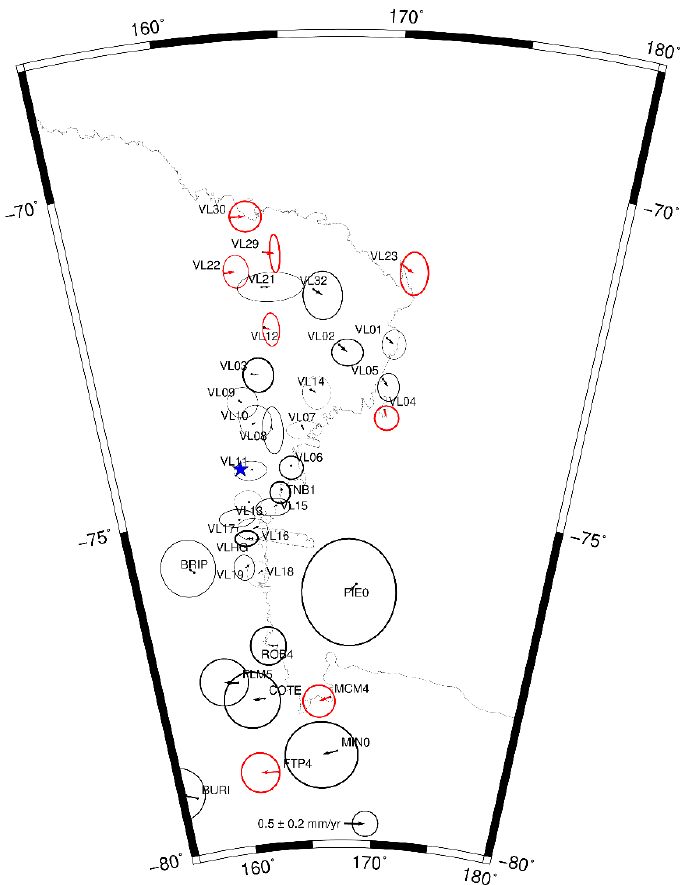
Figure 2. The difference between the relative velocities of the GNSS stations obtained using VLNDEF18 Euler pole and those obtained using the VLNDEF20 pole. Significant vectors are highlighted in red according to the ±σ criterion; blue star in the middle of the figure identifies the Euler pole of the differences. The horizontal principal strain rate and dilatation were evaluated at a center of each square cell of a regularly spaced grid, by means of the grid-distance-weighted approach [43,45–47]. The computation was done using all the 36 GNSS stations of the area and a distance weighting factor alpha of 38.67 km. Weighting data by distance produces a smoothed regional pattern strain and rotation rate field and is particularly effective to visualize the regional patterns over large areas. A grid spacing of 20 km was adopted to display the strain directions in the graphs in a more readable way, while a grid spacing of 5 km was adopted to highlight, by means of colored areas in the graph, only the significant values (at 1σ level). Figures 3 and 4 show the strain rate field computed from GNSS relative velocities. The Figure 3 shows the behavior of VL, where dilatation is shown in red and compression in blue. The Figure 4 shows the maximum shear strain rates and the direction of right- lateral component. Both figures highlight the heterogeneities of the deformations within VL.